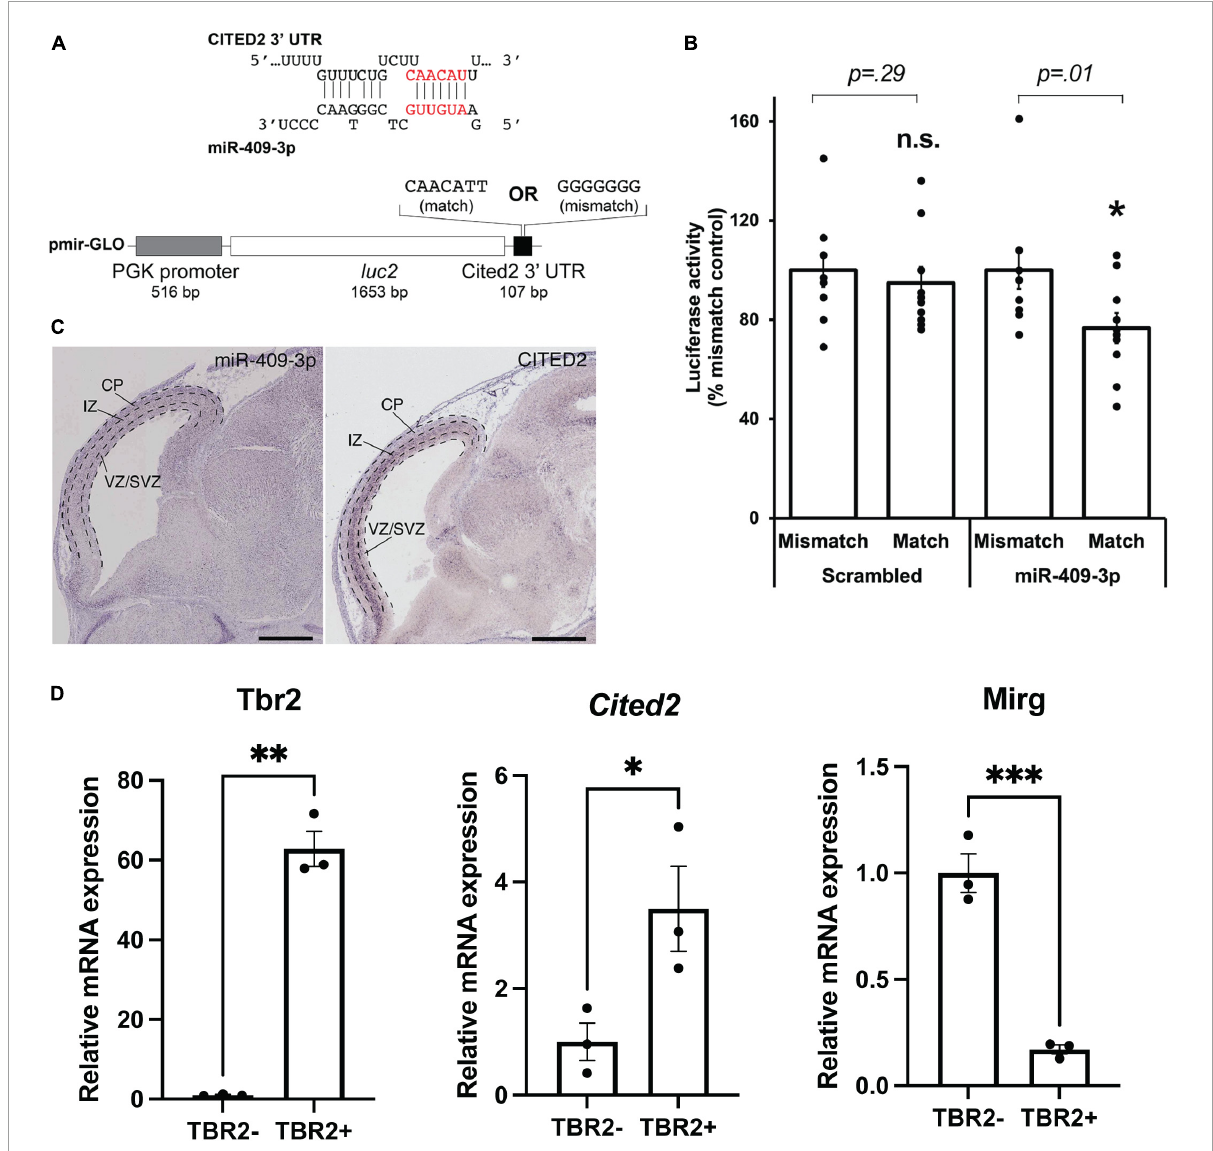
FIGURE1 miR-409-3p represses the transcriptional regulator Cited2 . (A) Sequence alignment demonstrating the predicted miR-409-3p target site in the Cited2 3 (cid:48) UTR. Seed sequence base-pairing is in red. Luciferase reporter constructs were generated with the Cited2 3 (cid:48) UTR fused to luc2 , containing the wild-type predicted miR-409-3p target sequence (match). Mismatch reporter vectors were identical except that the target sequence was replaced by a sequence that would not be recognized by miR-409-3p (mismatch). (B) miR-409-3p oligonucleotides repress